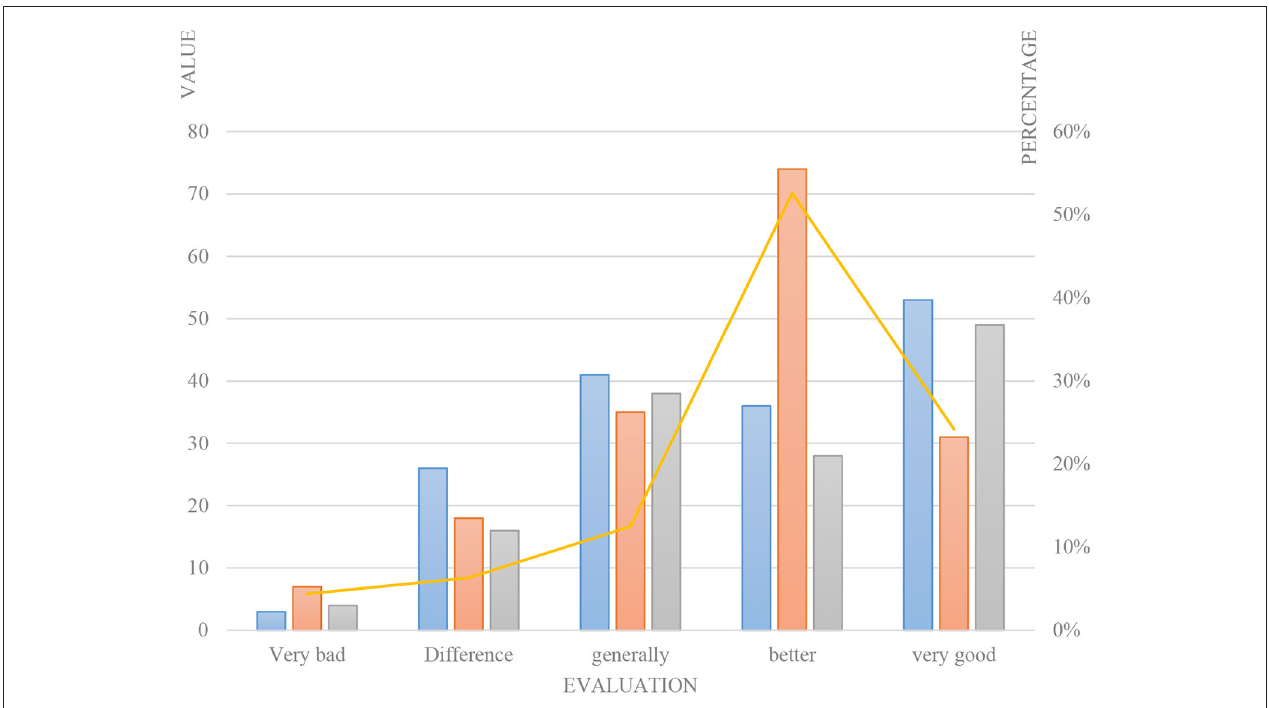
FIGURE 8 | Course interest survey